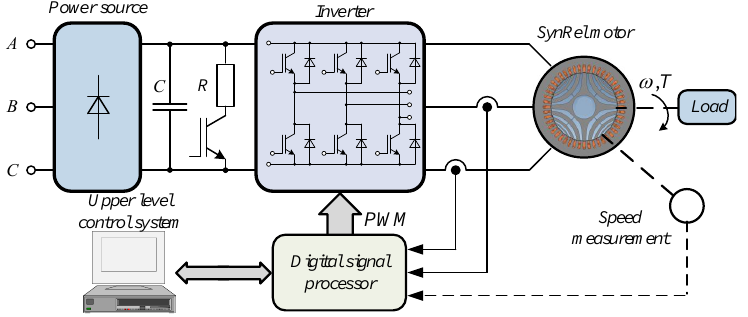
Figure 1. Typical electric drive